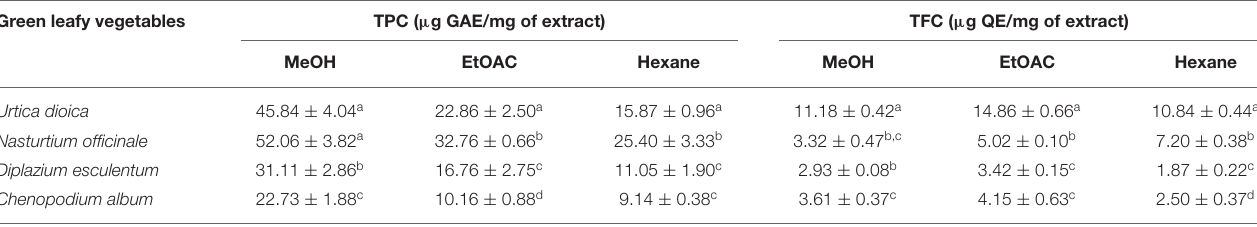
TABLE 3 | TPC and TFC in selected wild green leafy vegetables of Sikkim Himalayan region. Green leafy